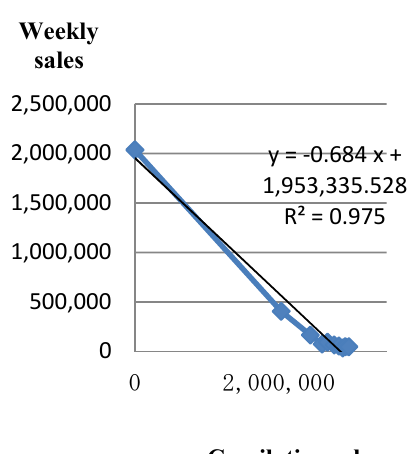
Figure 7. Fourt-Woodlock model (1960)